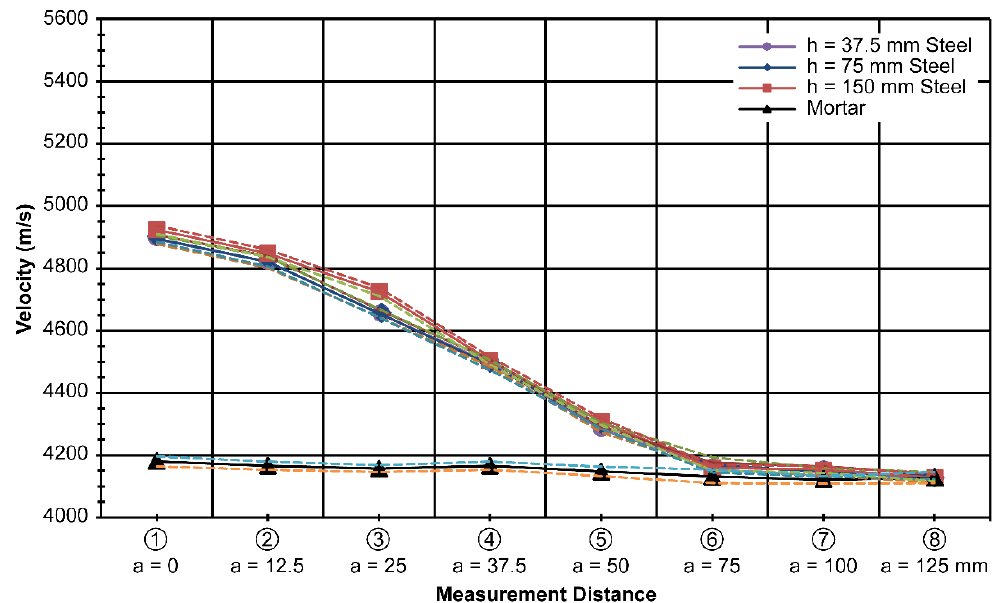
Figure 10. Measured velocity with varying height (h)at t = 20 mm and d = 75 mm.